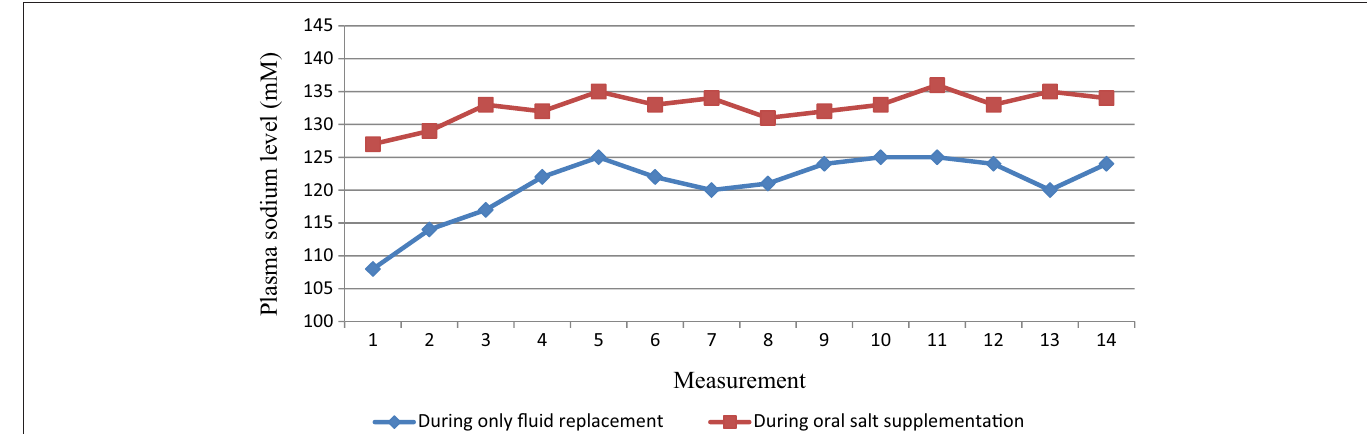
Measurement During only fluid replacement During oral salt supplementa(cid:30)on Figure 1. The course of plasma sodium levels for each